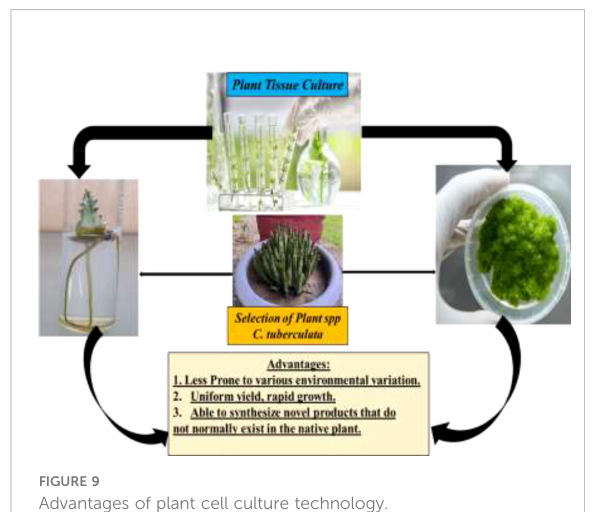
FIGURE 9 Advantages of plant cell culture technology.